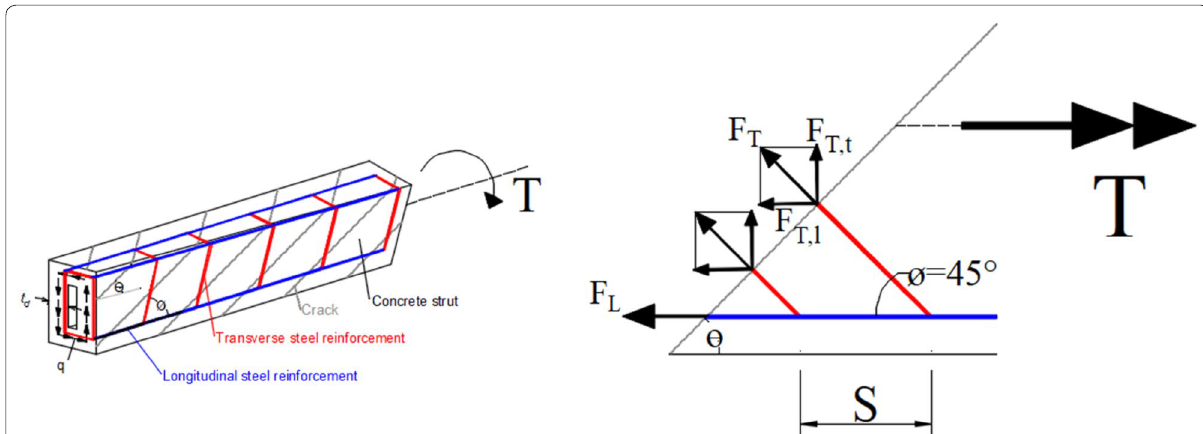
Fig. 14 Simplified torsional analysis based on the space truss